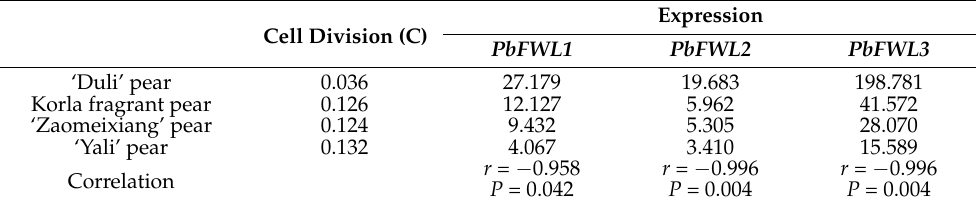
Table 2. Correlation between PbFWL1/2/5 expression and pulp cell devision in 10 to 40 DAFB.